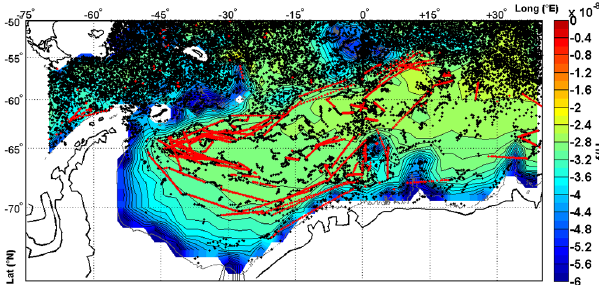
Figure 4. Argo float profile stations, with interpolated (under-ice) station locations are marked in red. The filled contours show lines of constant planetary potential vorticity, f/H . The grey contour shows the 2000m isobath.